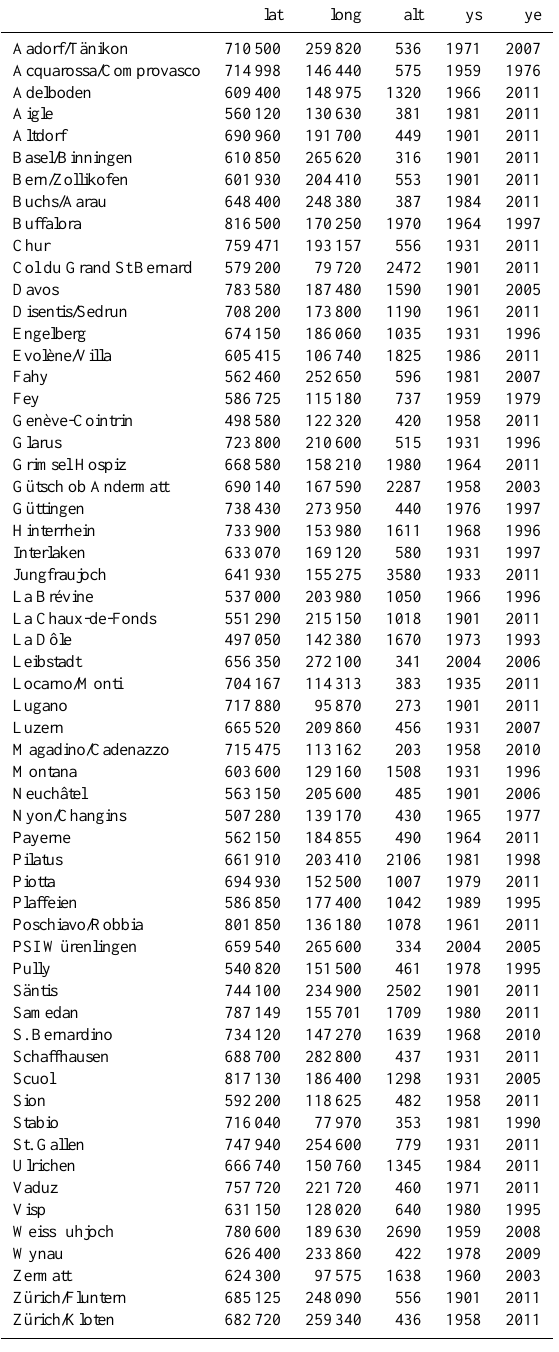
Table D1. Climate station data used to estimate cloud coverage. lat and long: latitude and longitude in meters, CH1903/lv03 (Swiss) coordi- nates; alt: altitude above sea level in meters; ys: first year of cloud coverage recording; ye: last year of cloud coverage recording. When cloud coverage was recorded at a station, precipitation was also